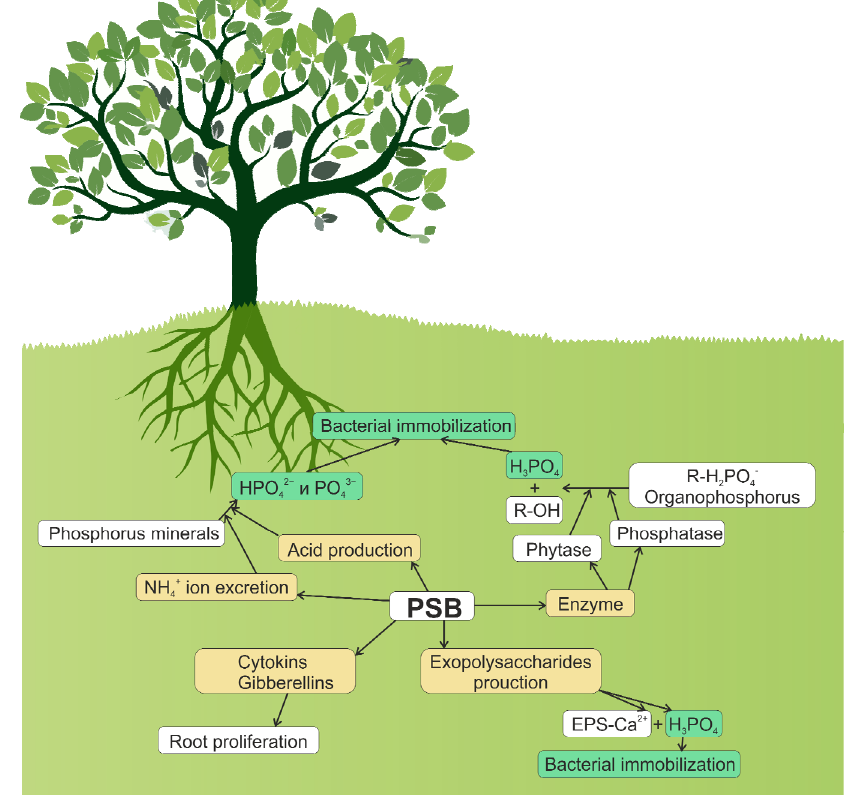
Figure 1. Role of PSBs in the solubilization of phosphates: solubilization of inorganic phosphates due to the synthesis of organic and inorganic acids; NH 4+ -excretion; solubilization of organic phosphorus-containing compounds due to the synthesis and excretion of enzymes; synthesis of polysaccharides, cytokinins, and gibberellins.